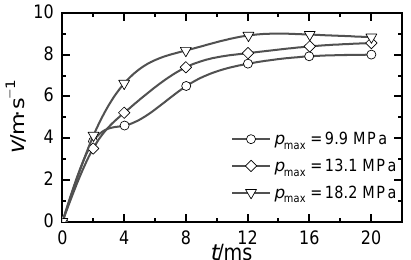
Figure 8. Projectile velocity under different maximum pressures.